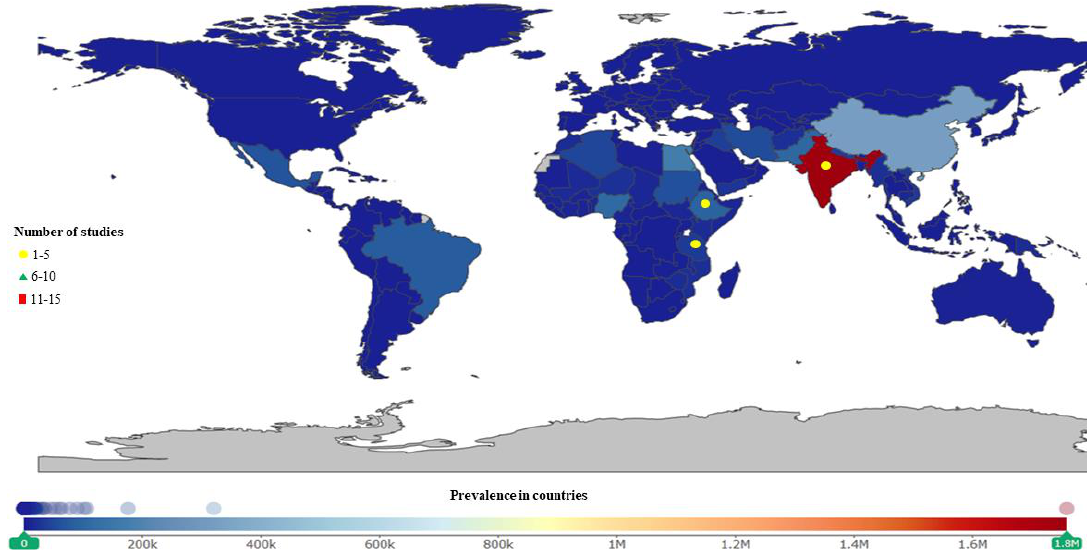
Figure 8. Onchocerciasis studies were conducted only in Africa (Cameroon, Ghana, and South Sudan). Onchocerciasis is highly prevalent in the DRC, Nigeria, and South Sudan. Source: The maps and prevalence of the studied neglected tropical diseases (NTDs) were created and retrieved from the Global Health Data Exchange [24].